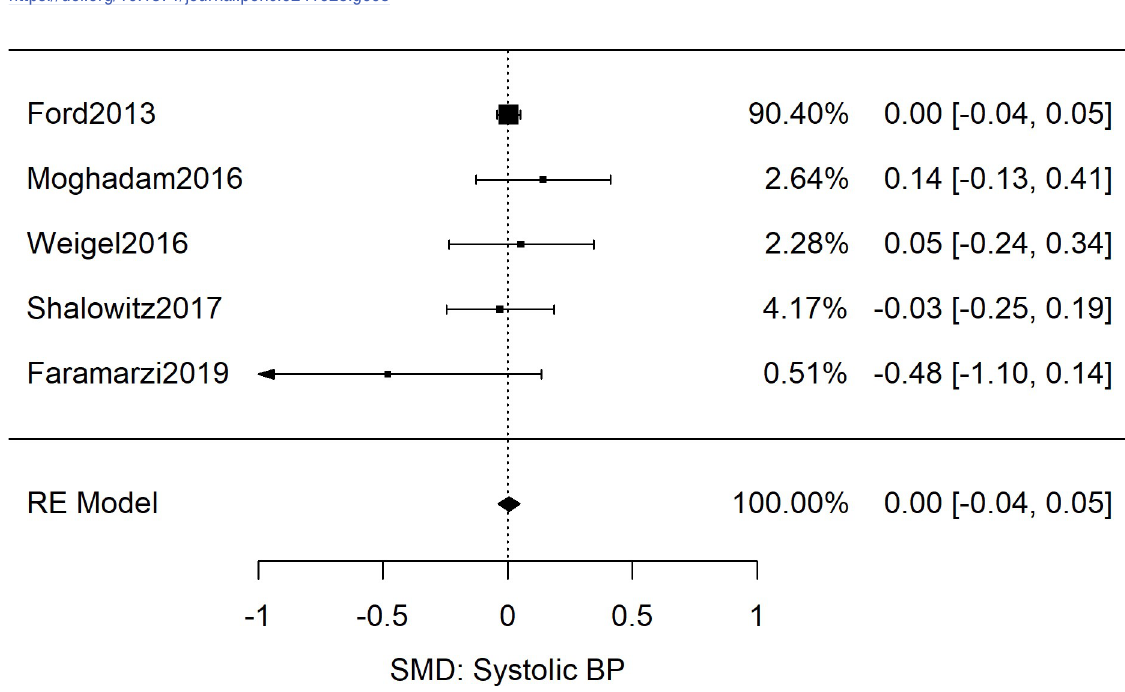
Fig 4. Meta-analysis of SMD of food insecurity and systolic blood pressure in adults. Shown are the results from 5 studies reporting systolic blood pressures as associated with food insecurity, resulting in a non-significant combined effect size ( g = 0.00 [95%CI: -0.04, 0.05; n = 12,122; Q ( df = 4) = 3.6; I 2 = 0%]).